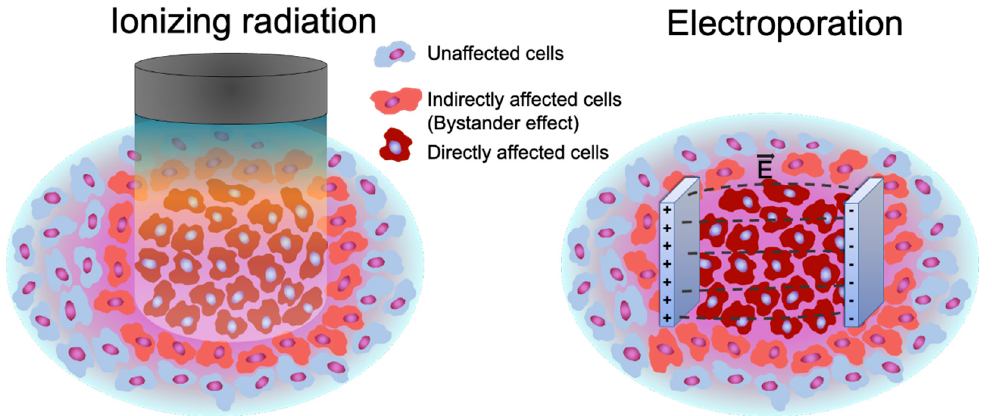
Figure 5. Visual representation of the bystander effect after ionizing radiation and electroporation trigger bleomycin electrotransfer. Three types of cells can be discriminated: directly affected cells, indirectly affected cells (bystander effect), and unaffected cells.